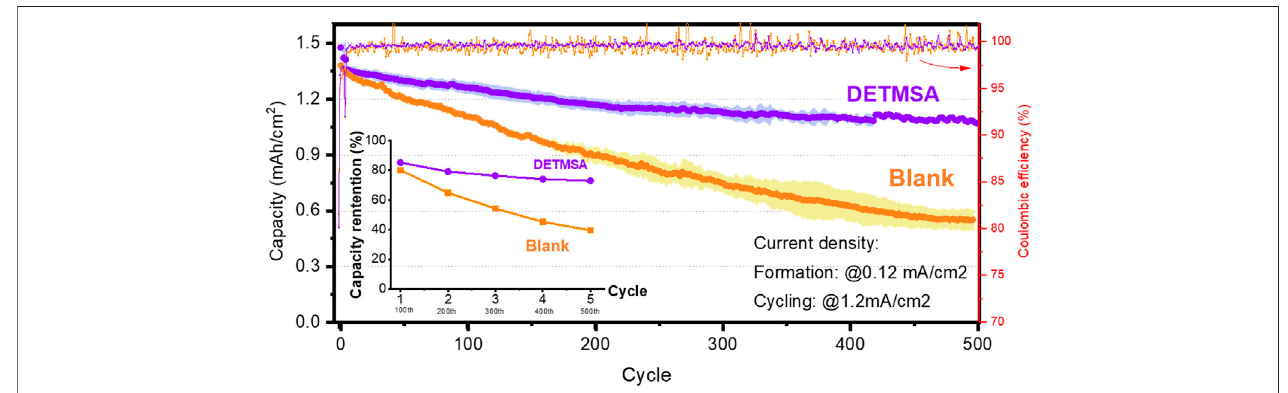
FIGURE 3 | The capacity performance of the full cell using different additives. Capacity retention after 100, 200, 300, 400, and 500 cycles at 1.2 mA/cm 2 after 5 cycles of formation process at 0.12 mA/cm 2